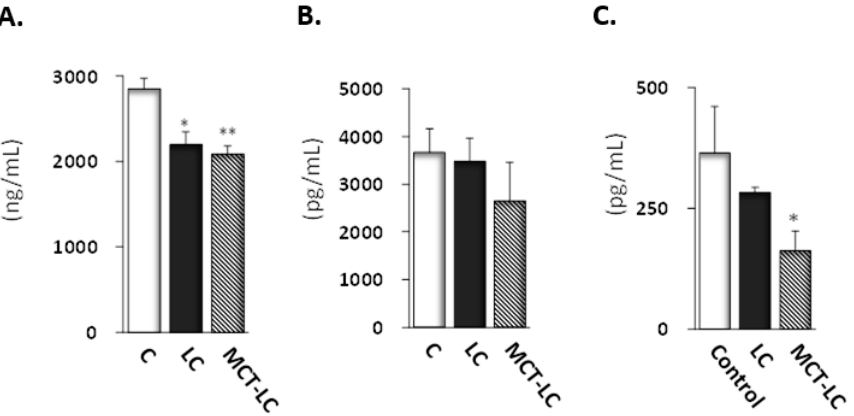
Figure 5. Adiponectin ( A ), leptin ( B ), and insulin ( C ) levels in fasting serum. Data shown are mean ± SEM. Control, control diet; LC, low-carbohydrate diet high in lard; MCT-LC, low-carbohydrate diet high in medium-chain triglyceride. * p < 0.05, ** p < 0.01 vs. control by the Tukey’s HSD test.